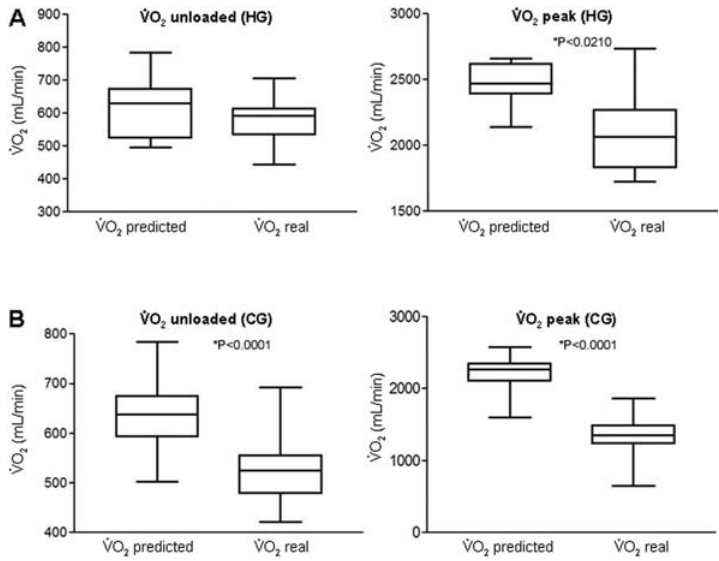
: Figure 2. Box plots of V O 2unloaded ð predicted Þ , : : : O 2unloaded ð real Þ , V O 2peak ð predicted Þ and V O 2peak ð real Þ V in the healthy group (HG) ( A ) and the coronary artery disease group (CG) ( B ). The nonparametric Wilcoxon test was used for statistical analysis. : O 2 : oxygen uptake. V